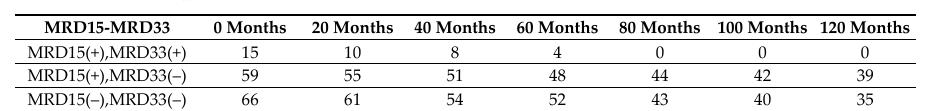
Number of patients at risk.